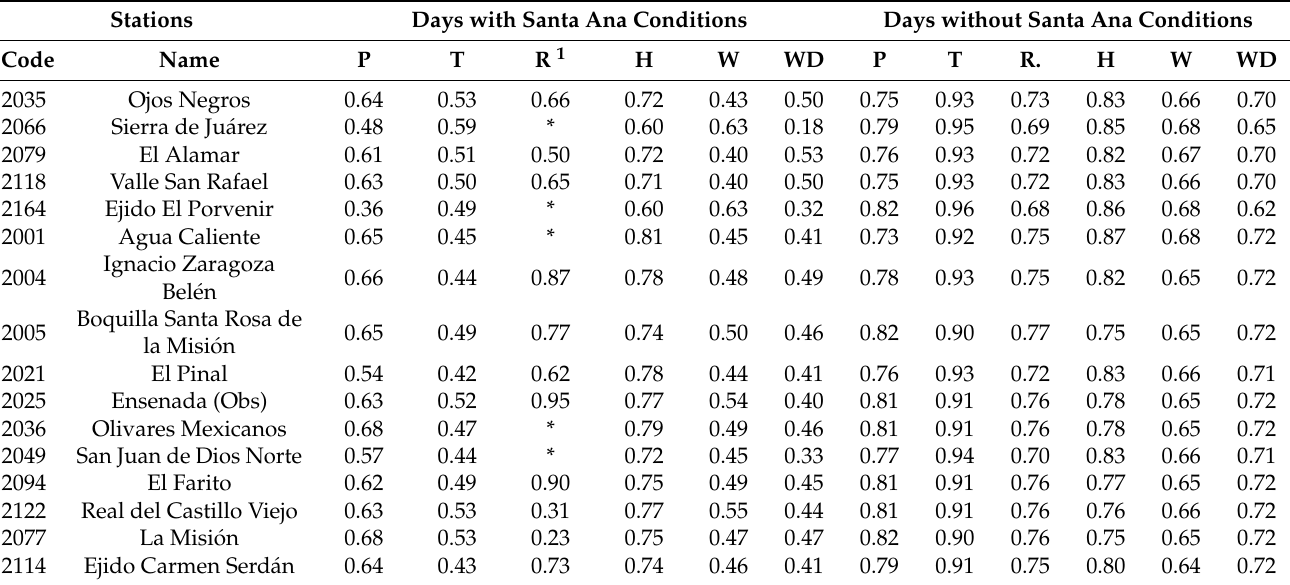
Table 3. Hurst exponent for the meteorological variables under study on the days with Santa Ana winds and days without Santa Ana